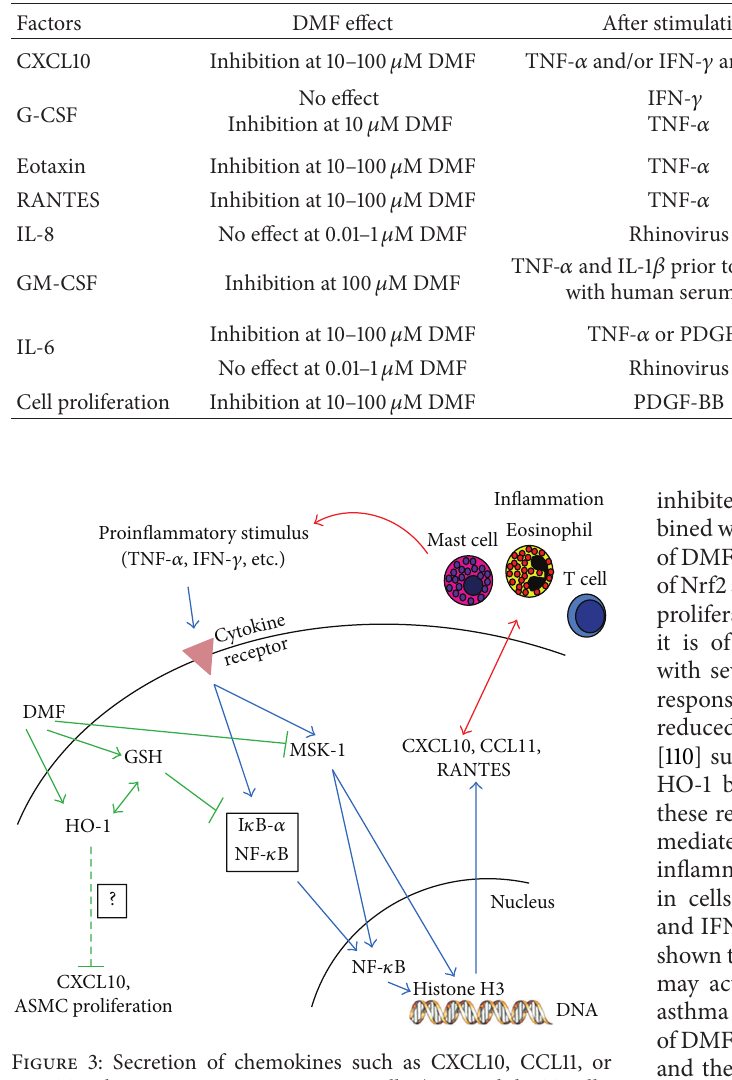
Table 1: DMF effects on primary human lung cells.